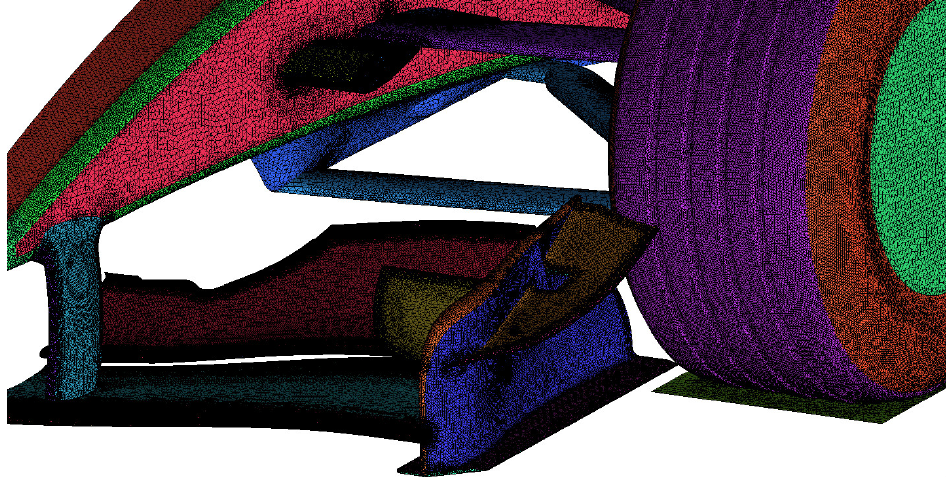
Figure 3. Detail of the calculation grid of the aileron’s vehicle.